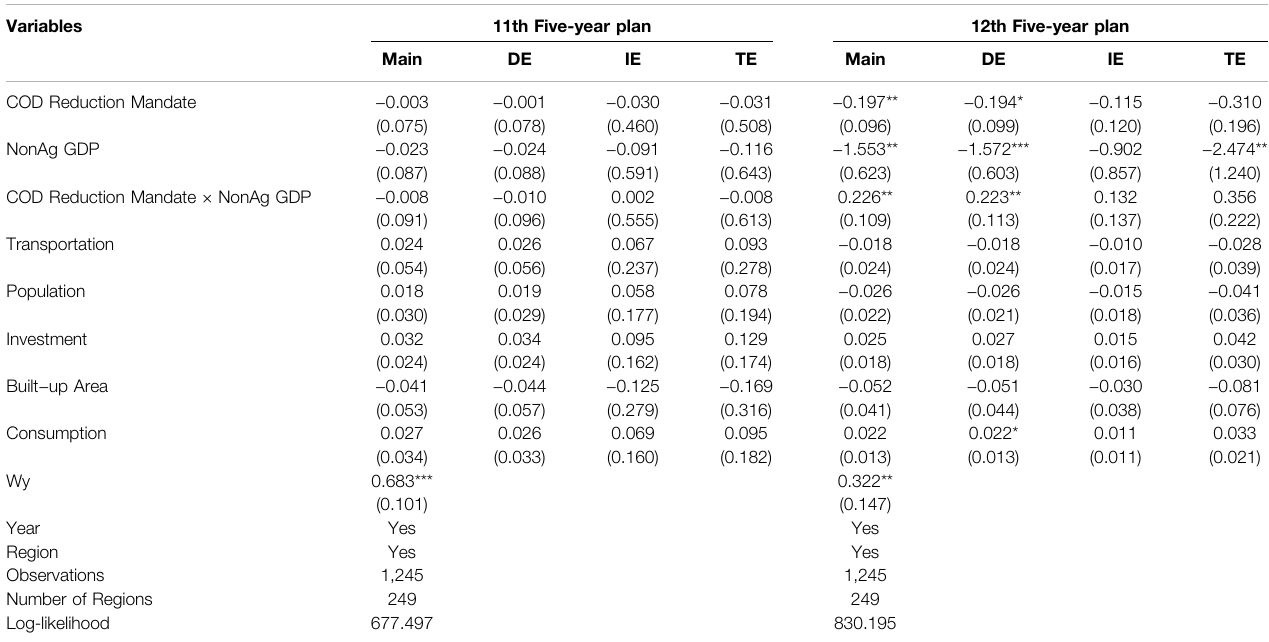
TABLE 3 | The main SAR